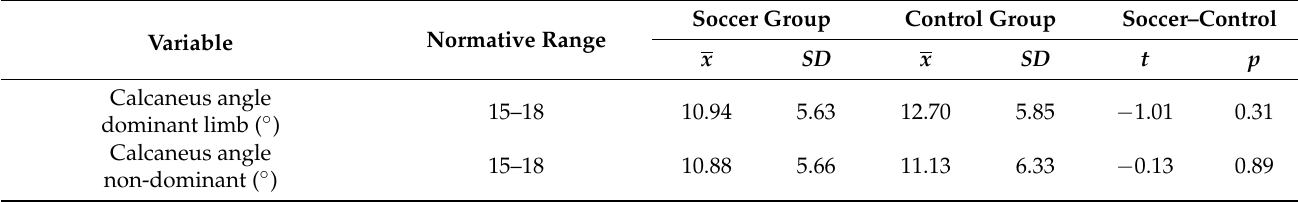
Table 2. Mean ( x ), standard deviation (SD) and t-test results for the calcaneus angle measures in the dominant and non-dominant limbs in the static test.